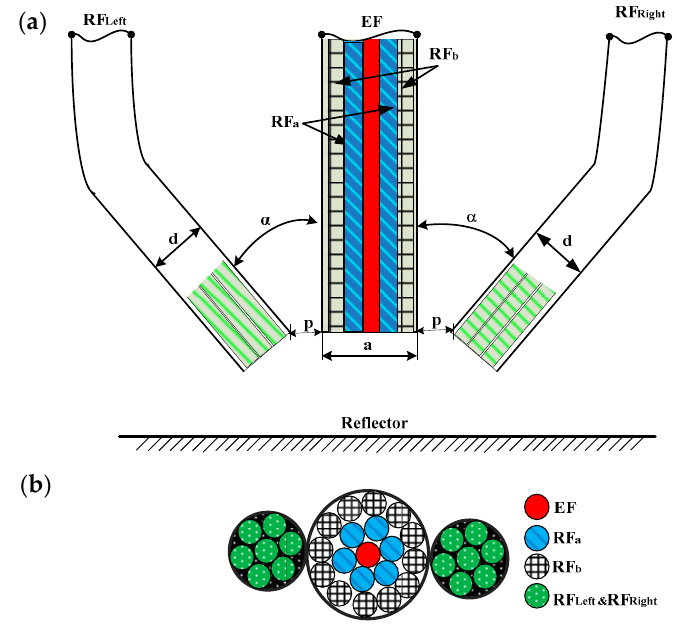
Figure 1. Structure of differential reflective intensity-modulated optical fiber angular displacement sensors: ( a ) sensor architecture; ( b ) the end face of sensor probe.